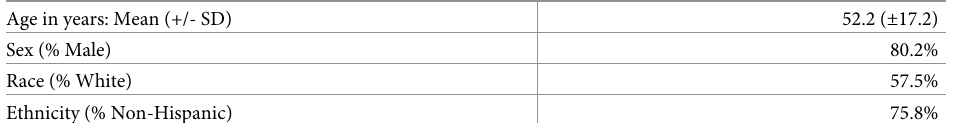
Table 1. Study population demographics. The population totaled 1,643,149